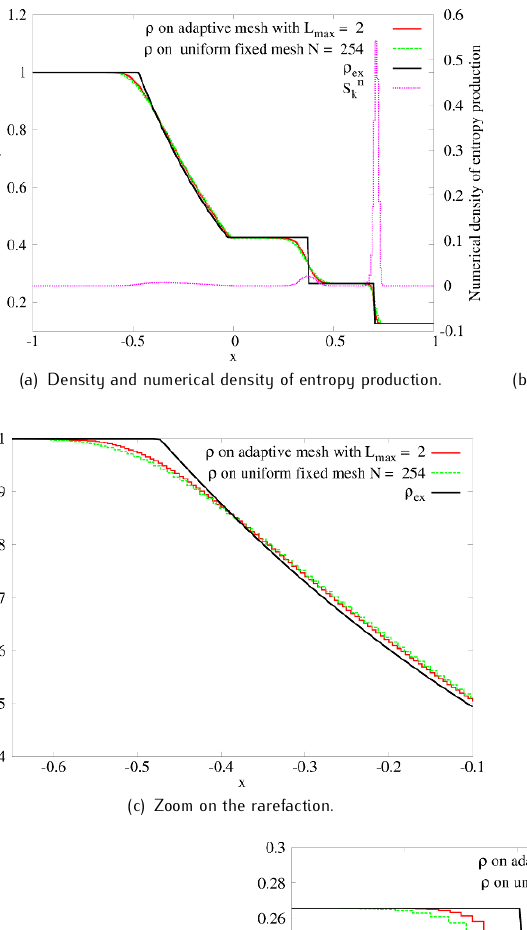
max = 2 and the AB1 scheme on